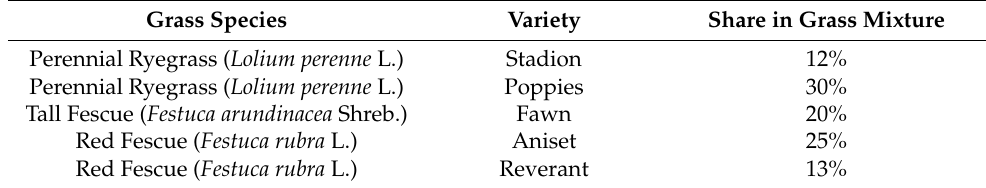
Table 2. Composition of evaluated grass mixture. Grass Species Variety Share in Grass Mixture Perennial Ryegrass ( Lolium perenne L.) Stadion 12% Perennial Ryegrass ( Lolium perenne L.) Poppies 30% Tall Fescue ( Festuca arundinacea Shreb.) Fawn 20% Red Fescue ( Festuca rubra L.) Aniset 25% Red Fescue ( Festuca rubra L.) Reverant